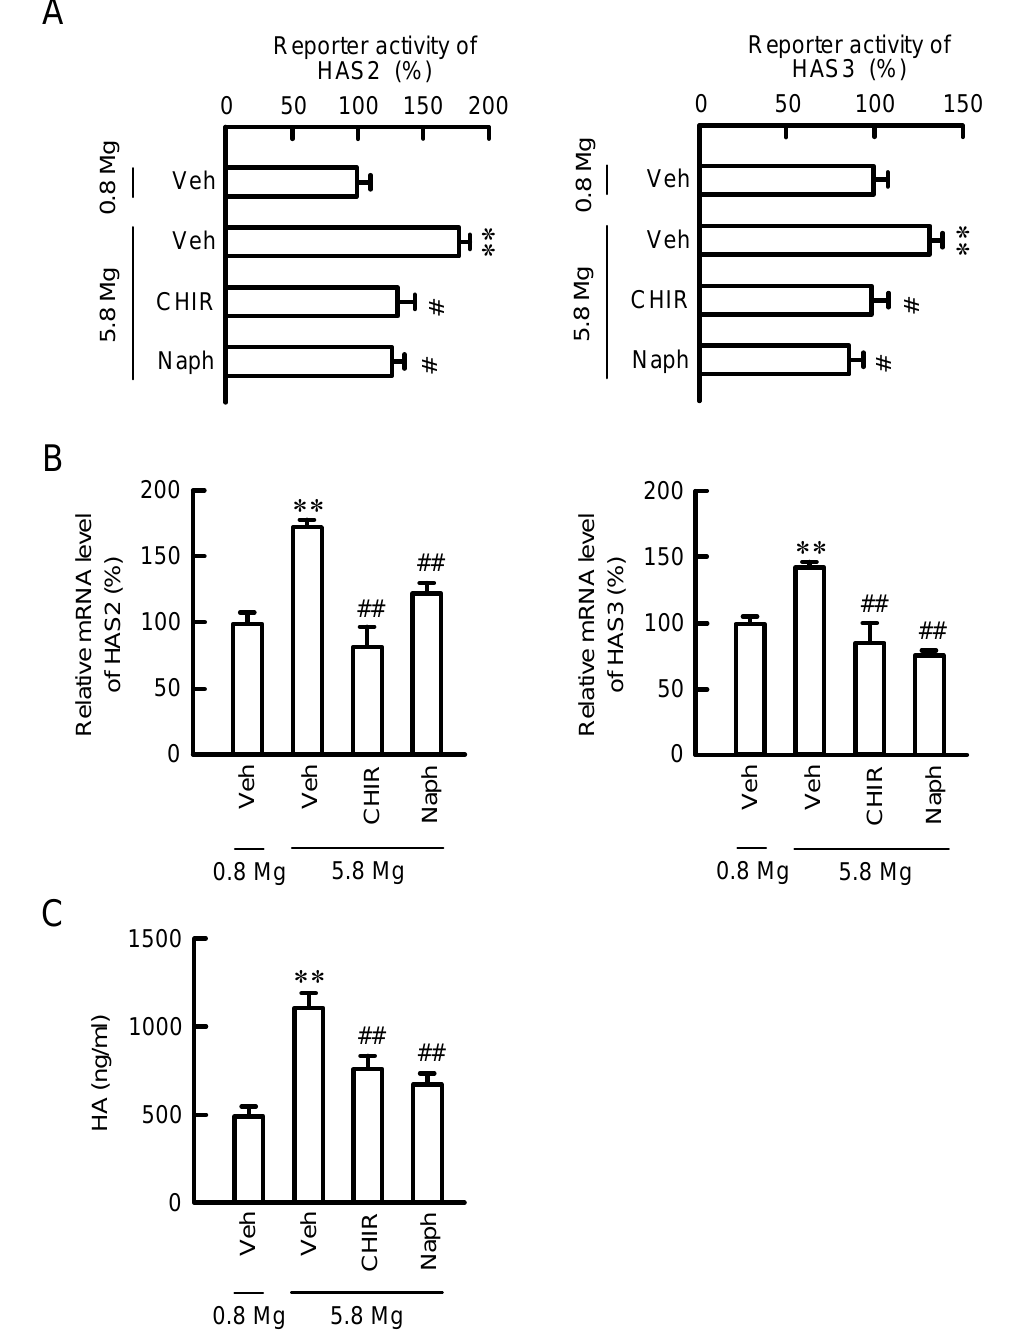
Figure 7. Effects of MgCl 2 supplementation and signaling inhibitors on HAS2/3 expressions and HA production. ( A ) Cells transfected with promoter reporter vectors for HAS2/3 were incubated in the absence (Veh) and presence of 10 µ M CHIR-99021 (CHIR) or 10 µ M naphthol AS-E (Naph) for 6 h. The reporter activities of HAS2/3 are represented as a percentage of 0.8 mM MgCl 2 . ( B ) Cells were incubated in the absence (Veh) and presence of 0.8 mM MgCl 2 , 5.8 mM MgCl 2 , 10 µ M CHIR-99021 (CHIR) or 10 µ M naphthol AS-E (Naph) for 6 h. The mRNA levels of HAS2/3 are represented as a percentage of 0.8 mM MgCl 2 . ( C ) Cells were incubated in the absence (Veh) and presence of 0.8 mM MgCl 2 , 5.8 mM MgCl 2 , 10 µ M CHIR-99021 (CHIR) or 10 µ M naphthol AS-E (Naph) for 24 h. After collecting the media, HA contents were measured using a Hyaluronan Quantification kit. n = 4–6. ** p < 0.01 significantly different from 0.8 mM MgCl 2 . ## p < 0.01 and # p < 0.05 significantly different from 5.8 mM MgCl 2 plus 5.8 mM MgCl 2 .